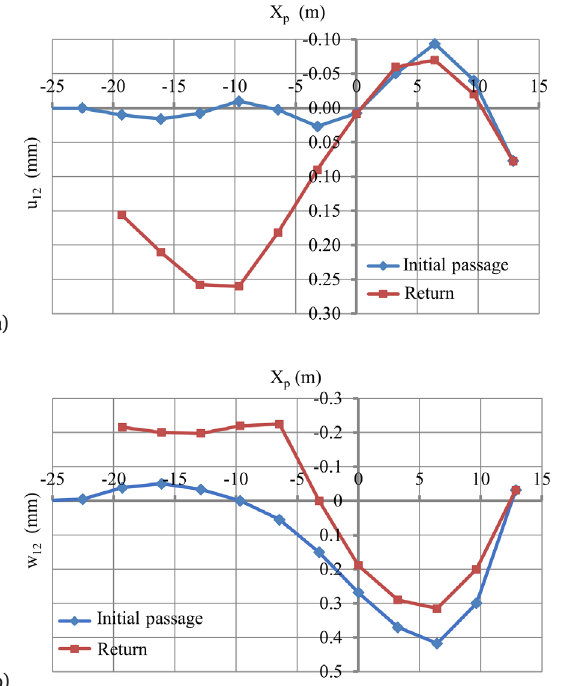
Figure 7: Horizontal (a) and vertical (b) displacement of point 12 during the loading